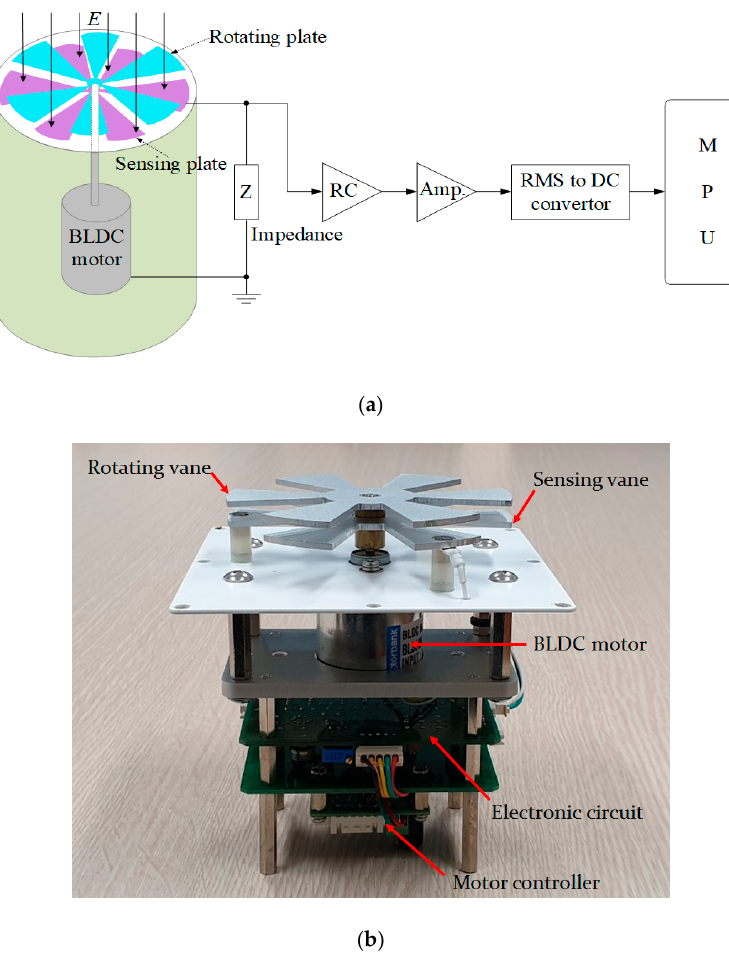
Figure 2. Electric field mill (EFM) sensor. ( a ) Configuration; ( b ) photograph.